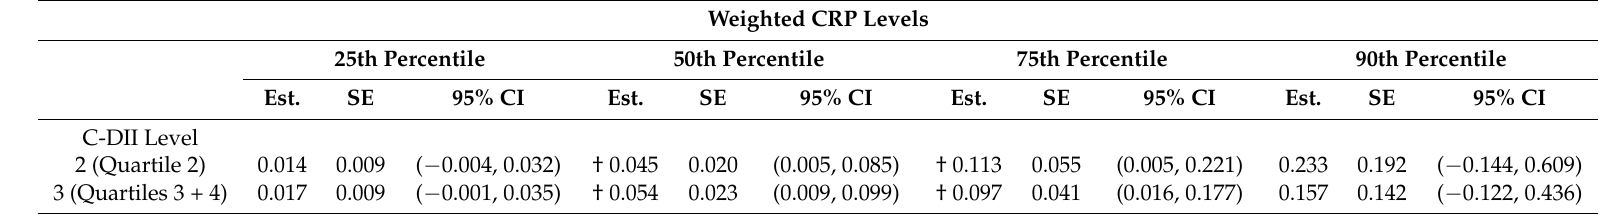
Table 2. The quantile regression coefficients for children’s dietary inflammatory index treated categorically with 3 levels (level 1 is the reference level) adjusted for sex, age, race, asthma, BMI and infection, NHANES, 2005–2012 * . Weighted CRP